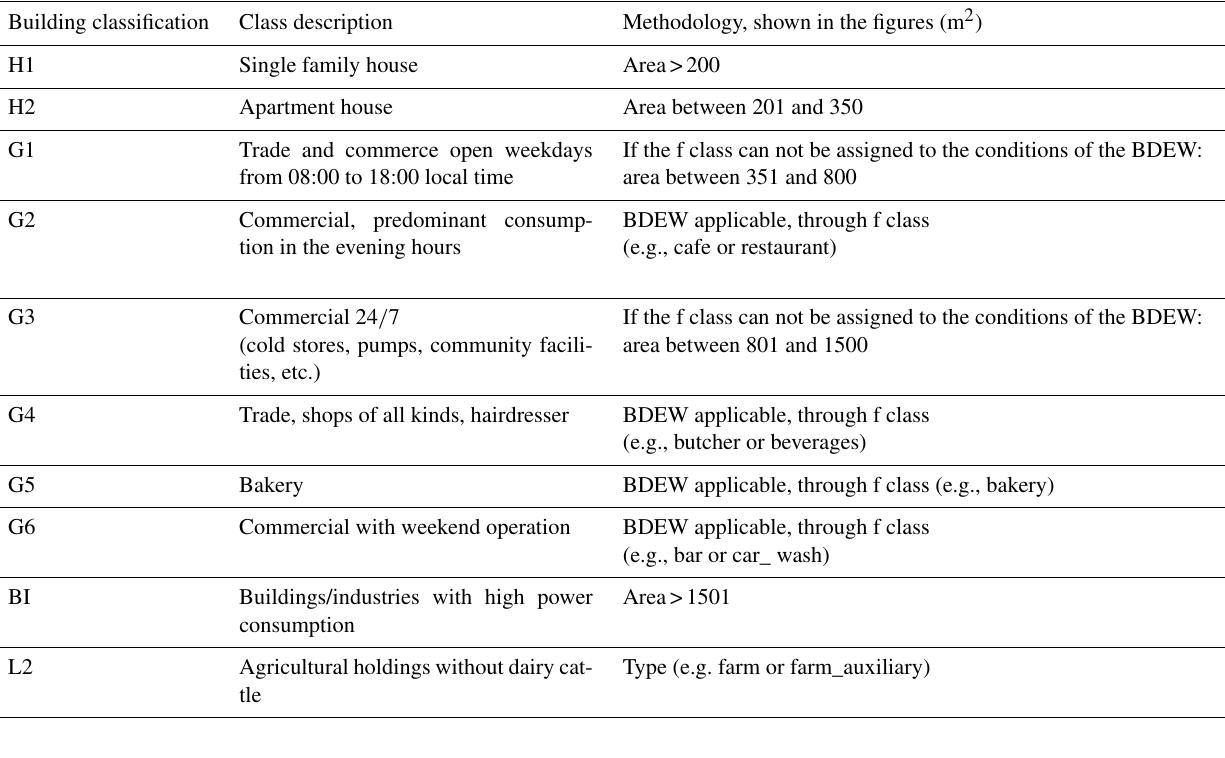
Table 1. OSM data before and after the prevalidation.